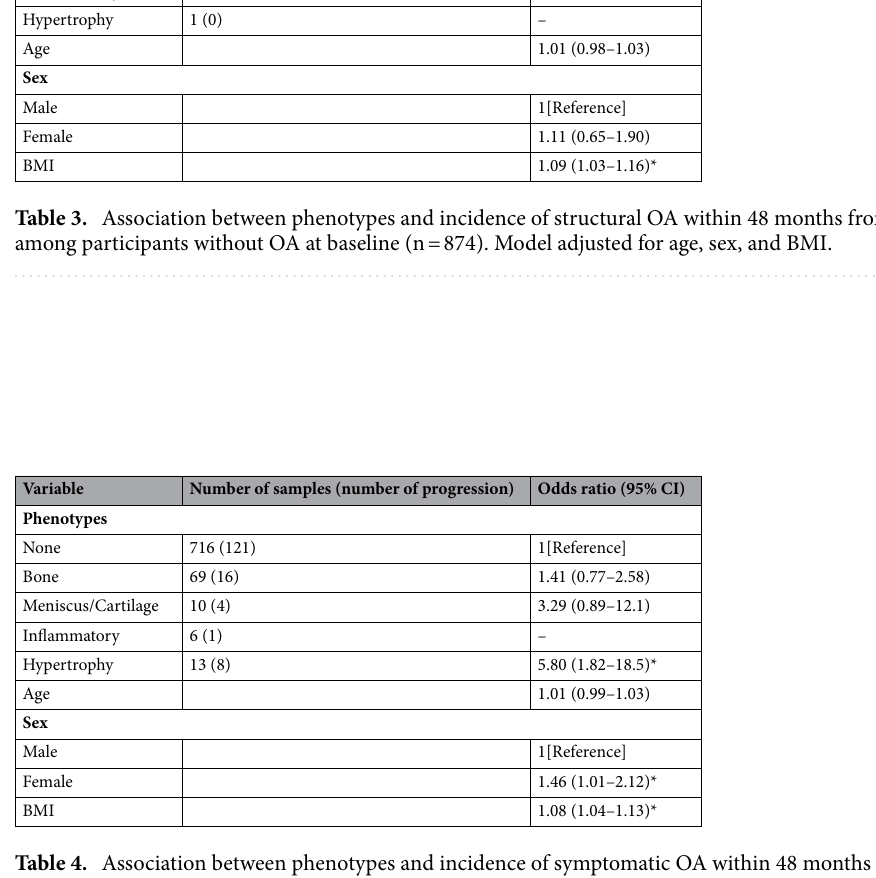
Table 4. Association between phenotypes and incidence of symptomatic OA within 48 months from baseline among participants without OA at baseline (n = 814). Model adjusted for age, sex, and BMI.